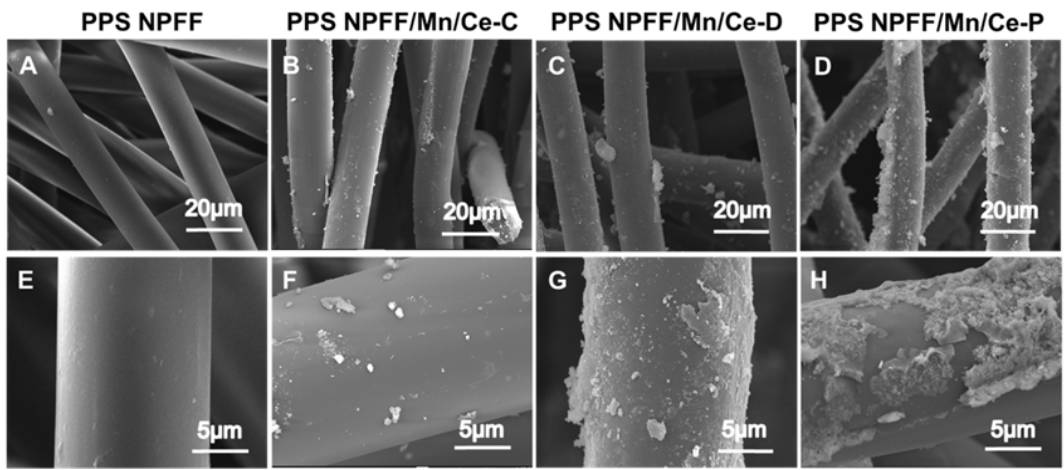
Figure 4. ( A – D ) Scanning electron microscopy (SEM) images and ( E – H ) FE-SEM (Field emission scanning electron microscopy) images of the original PPS NPFF and the three different Mn/Ce oxides decorated PPS NPFF.